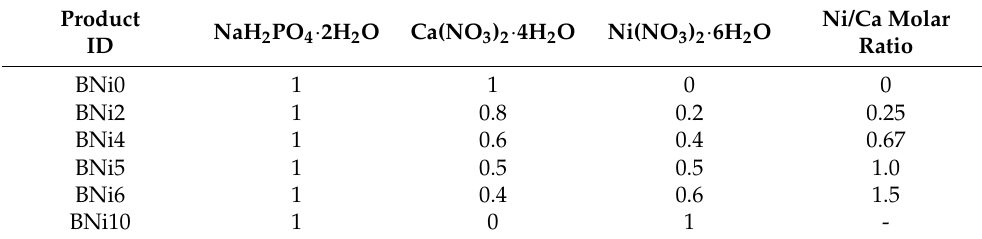
Table 1. Molar proportions of NaH 2 PO 4 · 2H 2 O, Ca(NO 3 ) 2 · 4H 2 O, and Ni(NO 3 ) 2 · 6H 2 O, as well